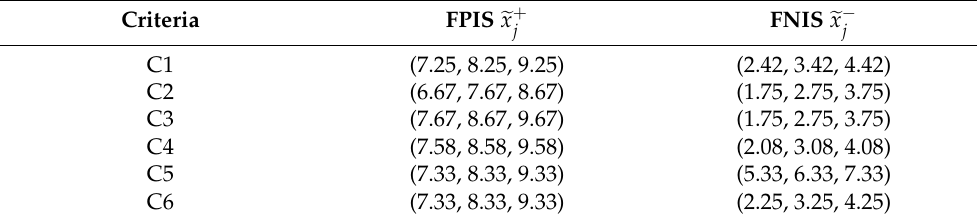
Table 8. The FPIS (fuzzy positive ideal solution) and FNIS (fuzzy negative ideal